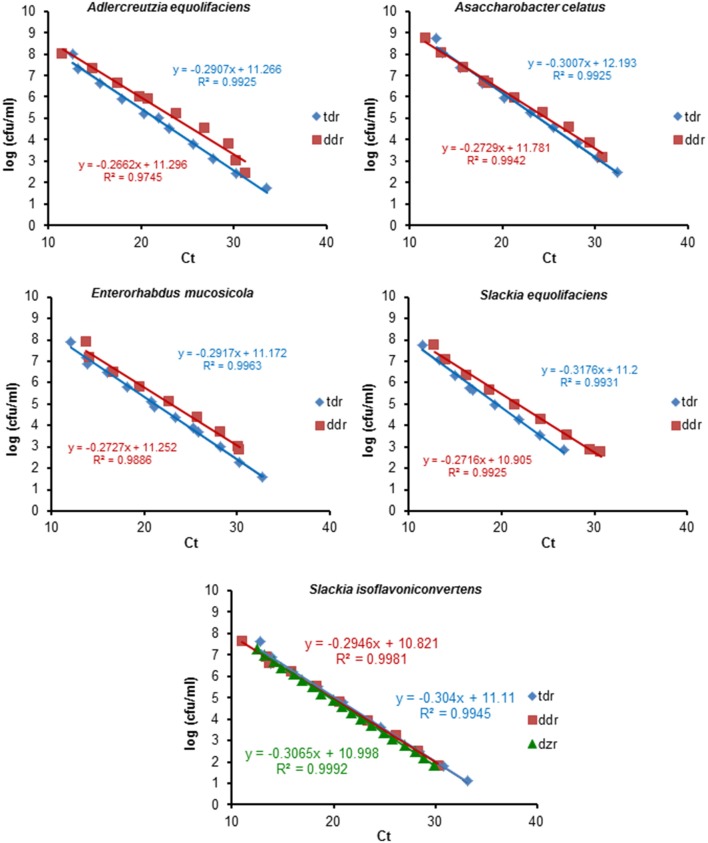
Standard curves of qPCR for the tetrahydrodaidzein reductase (tdr) and the dihydrodaidzein reductase (ddr) target genes using serial dilutions of DNA from known amounts of cells of equol-producing microorganisms. Linear regression was obtained plotting the cycle threshold (Ct) values vs. the log10 of the counting results (in cfu/ml). The equation and R2 value of the regression lines are indicated in each panel.